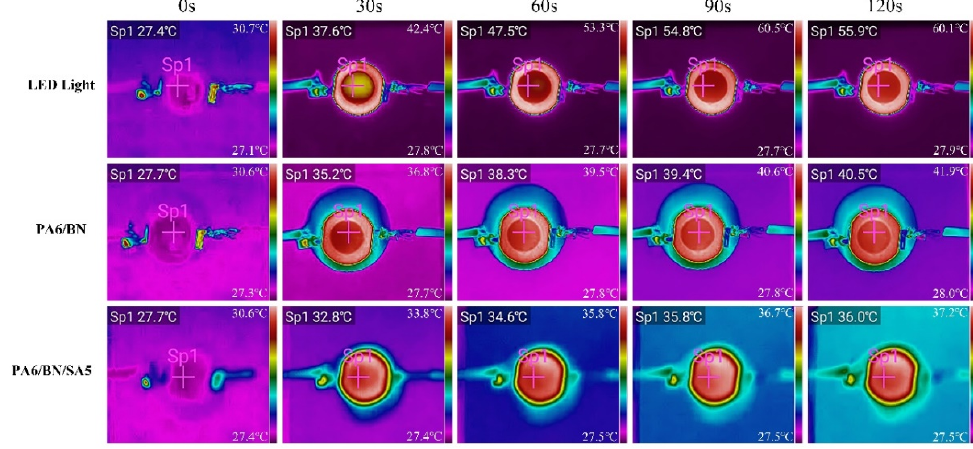
Figure 6. Thermal images of LED lamps.